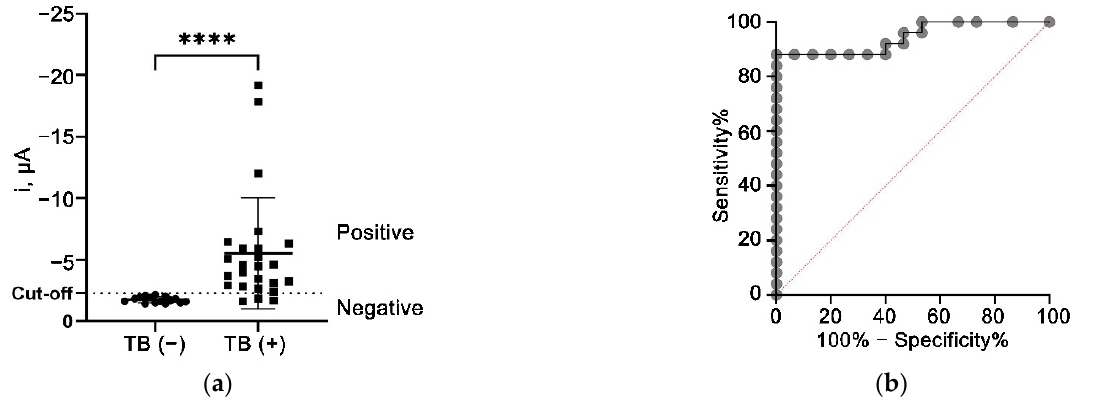
Figure 8. Evaluation of the aptasensor using clinical sputum samples from individuals infected with TB (TB (+)) and control non-TB individuals (TB ( − )). ( a ) Scatter plot of amperometric current response between TB (+) and TB ( − ) individuals. Group comparison analysis was performed using the Mann–Whitney test. **** denotes p < 0.0001. ( b ) ROC curve analysis between TB (+) and TB ( − ).